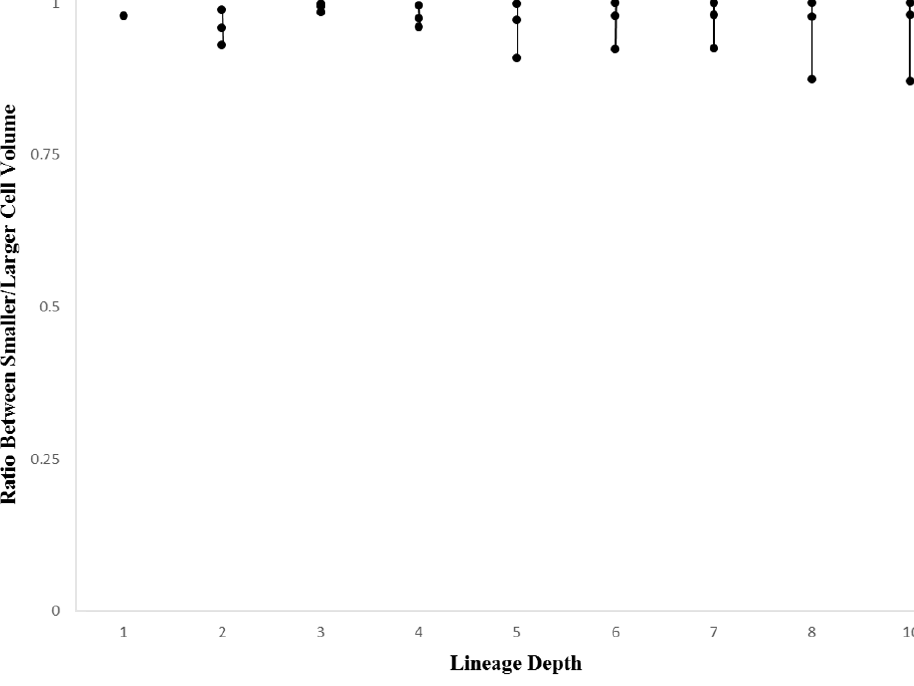
Figure 10. Maximum, mean, and minimum values (black dots from top to bottom) for smaller cell volume to larger cell volume ratios for C. elegans summarized by lineage depth (values per division event).